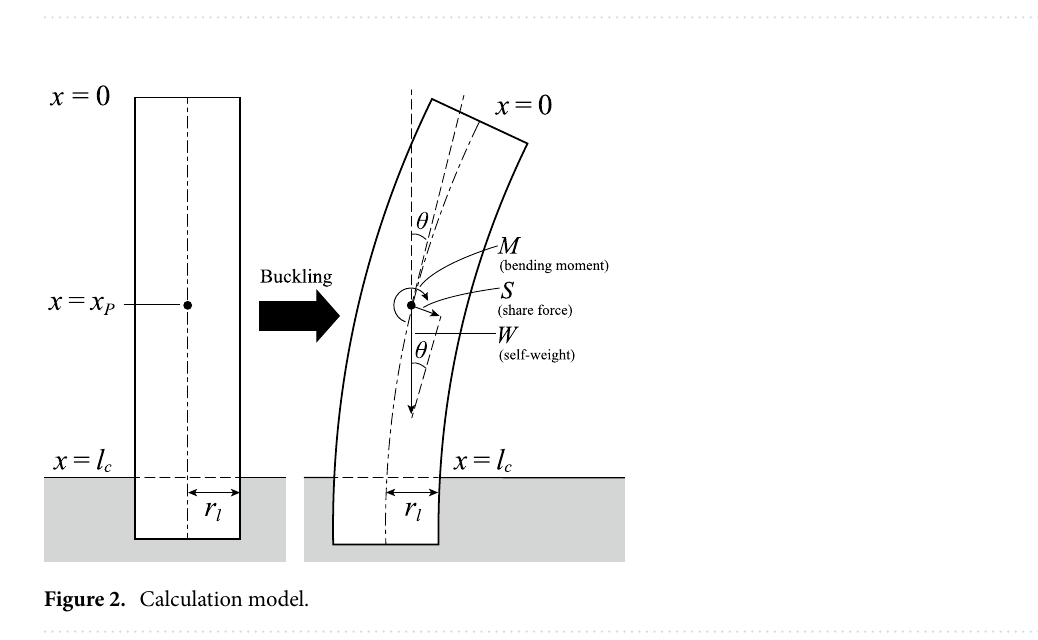
Table 1. Calculation models and related numerical conditions.